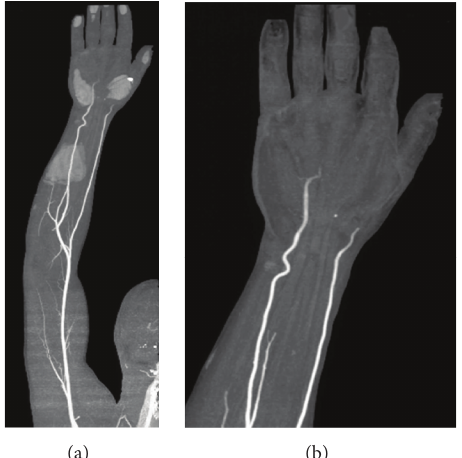
Figure 1: CT angiography of the right upper arm ((a) and (b)). The tridimensional reconstruction (MIP ( Maximum Intensity Projection ) technique) of the arterial circulation showed the interruption of both the radial and ulnar artery flow at level of the thenar and hypothenar eminences and the absence of distal circulation.